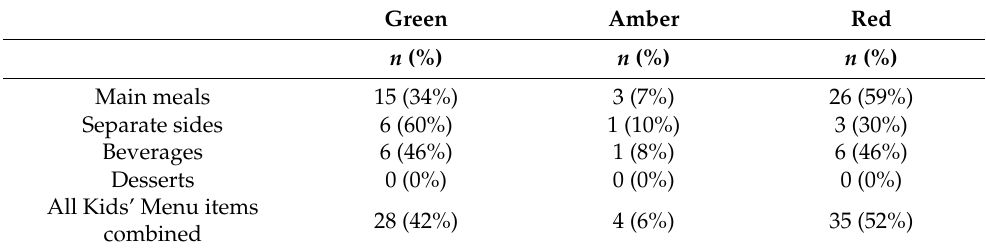
Table 5. Nutrition assessment of the top 10 fast-food chain Kids’ Menu items using the Traffic Light System of food classification.